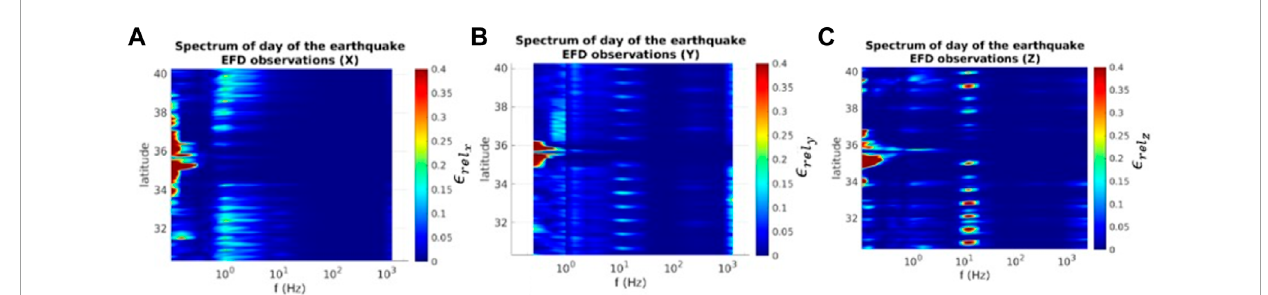
FIGURE 11 CSES-01/EFD spectra for 27 September 2021, 17 hours before the event, on the same 6° × 6° LAT-LON cell. In this case, no clear signal emerges from the background.